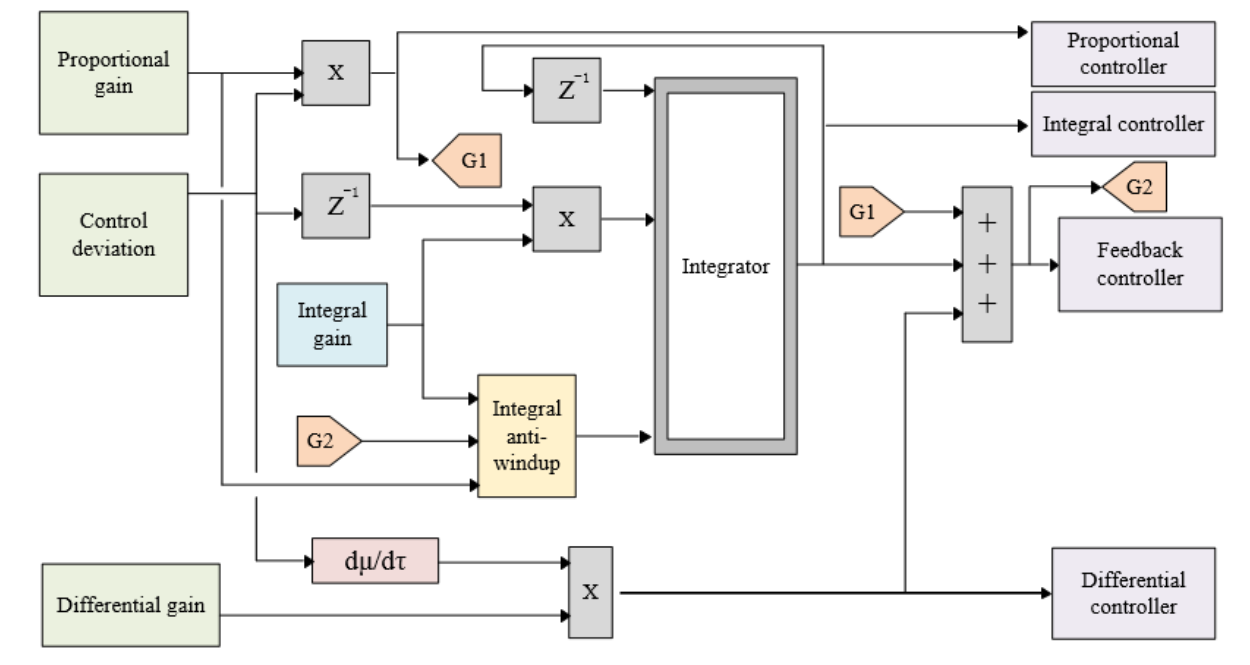
Figure 14. Algorithm design of PID feedback control path.